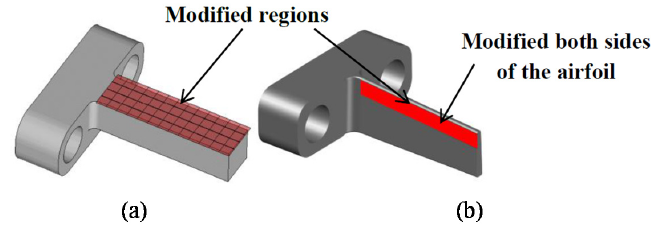
Figure 2. Typical T-shaped flat ( a ) and airfoil ( b ) samples that were machined.